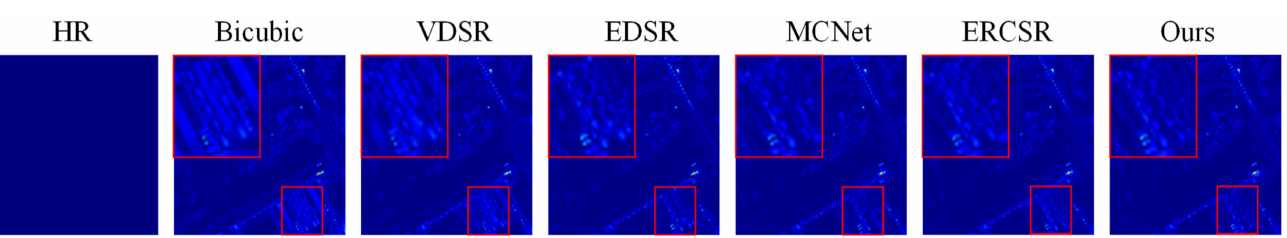
Figure 11. Absolute error map comparisons for test images in the Pavia University dataset of various algorithms with a scale factor of 8. As the box in the figure shows, our method has the smallest residual and better edge information recovery, so it looks closer to dark